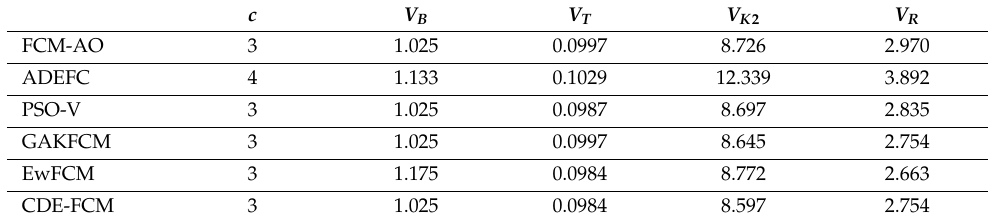
Table 7. Performance of algorithms on Wine data.